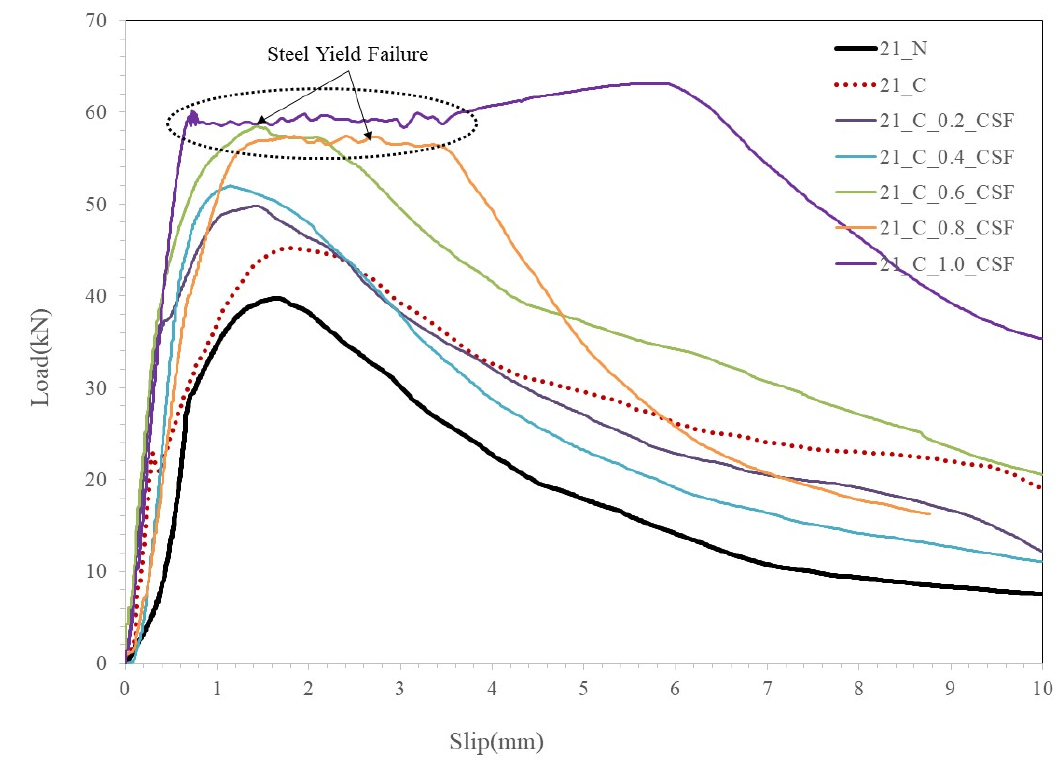
Figure 6. Load–slip curves with crimped steel fiber.